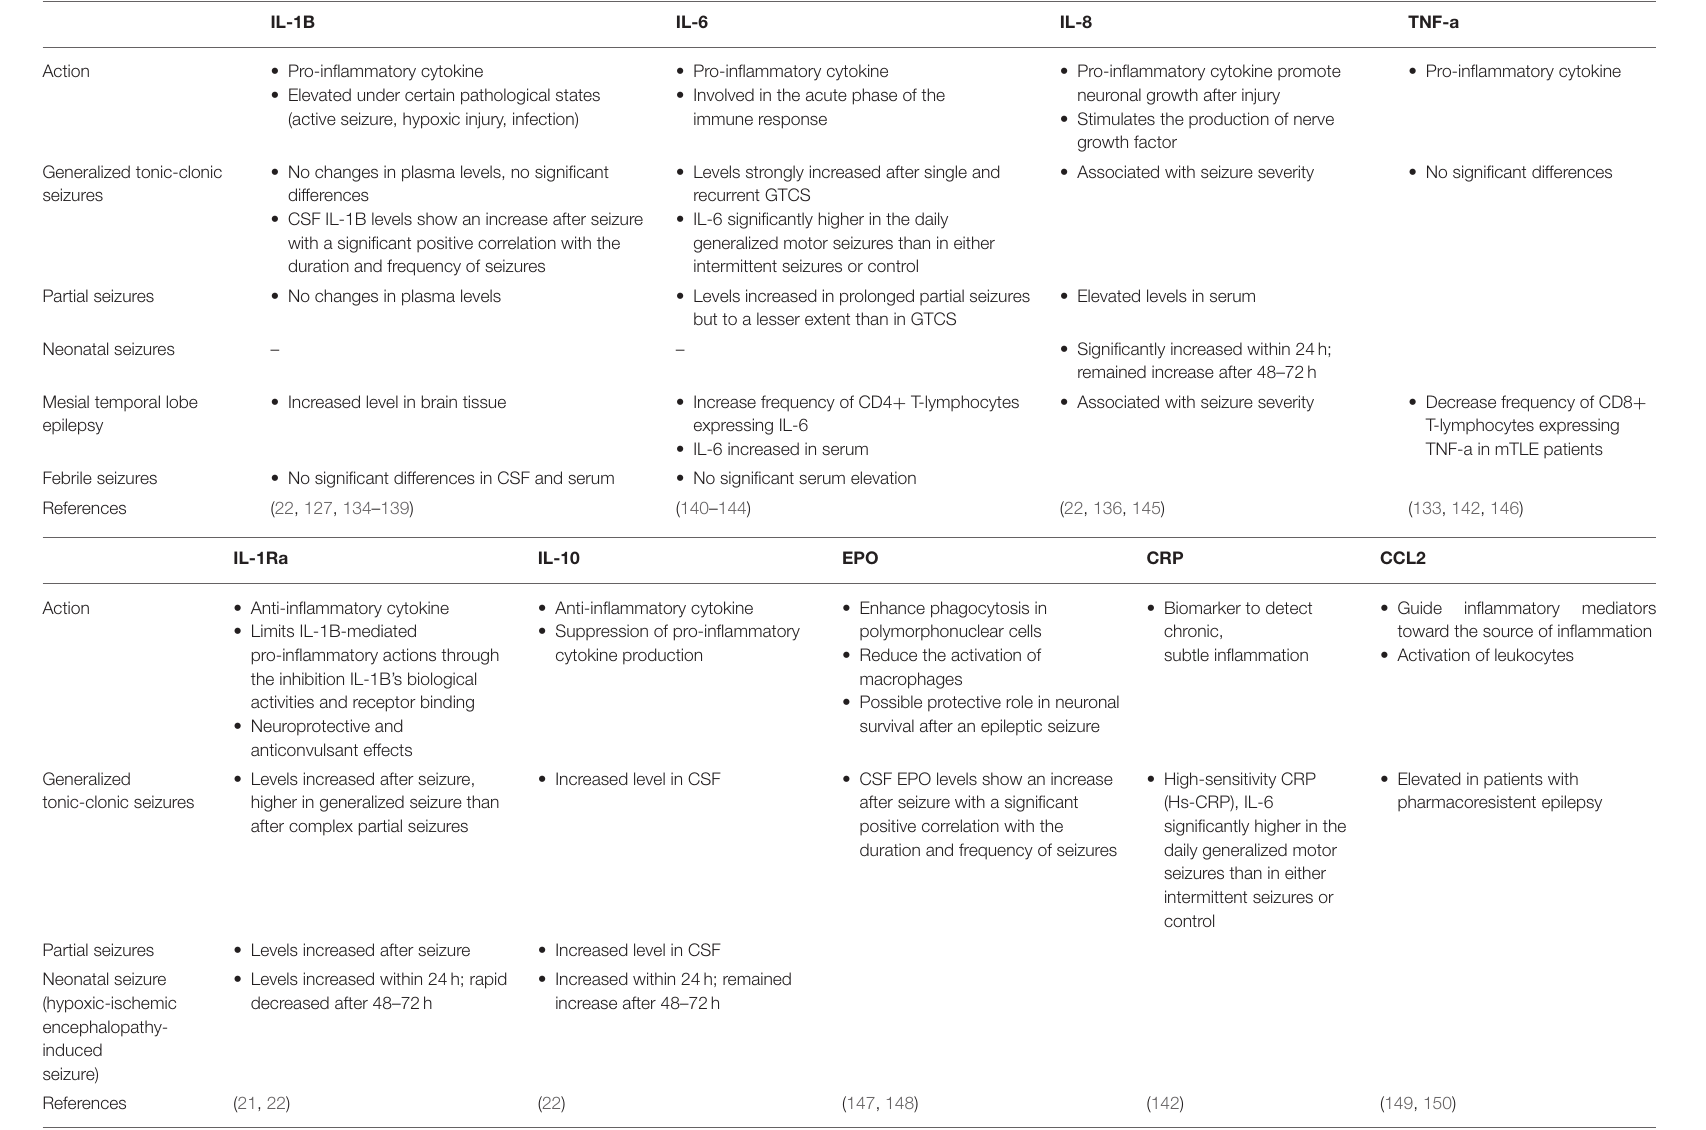
TABLE 2 | Cytokines and their main role in